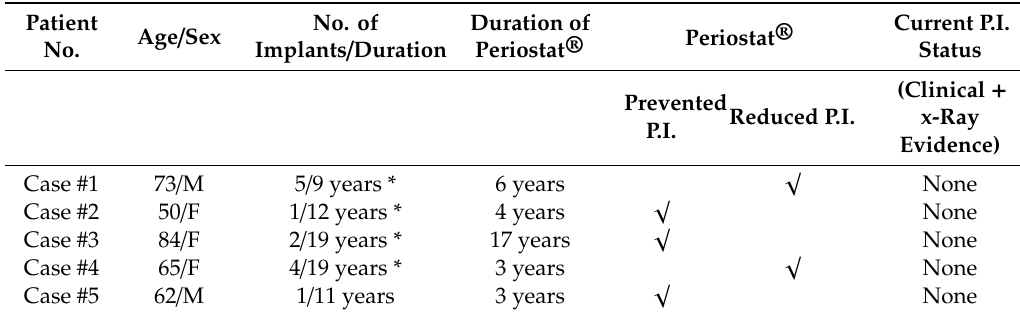
Table 1. Prevention and / or treatment of peri-implantitis by oral (systemic) host-modulation therapy (subantimicrobial-dose doxycycline, SDD).